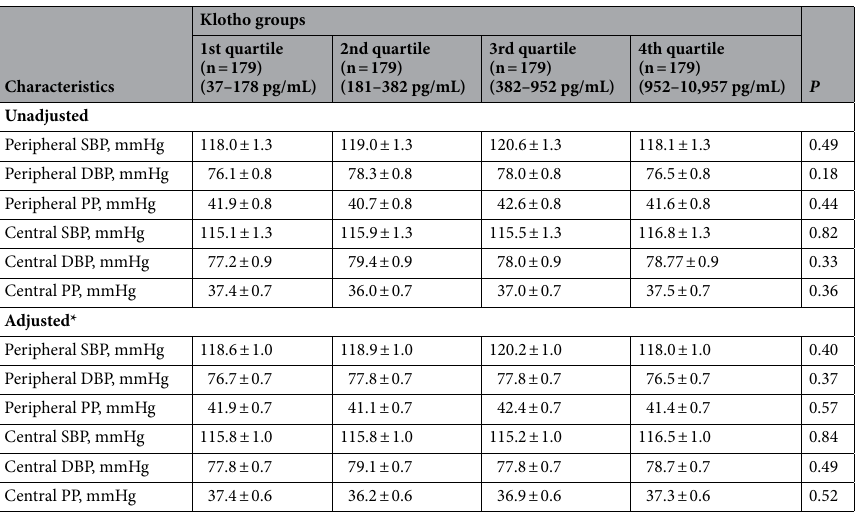
Table 3. Peripheral and central blood pressure in relation to the serum klotho concentration. Values are presented as means ± standard errors. *Values are adjusted for age, sex, body mass index, glomerular filtration rate, hypertension, diabetes status, antihypertensive treatment, current smoking, and alcohol intake. DBP diastolic blood pressure, PP pulse pressure, SBP systolic blood pressure.